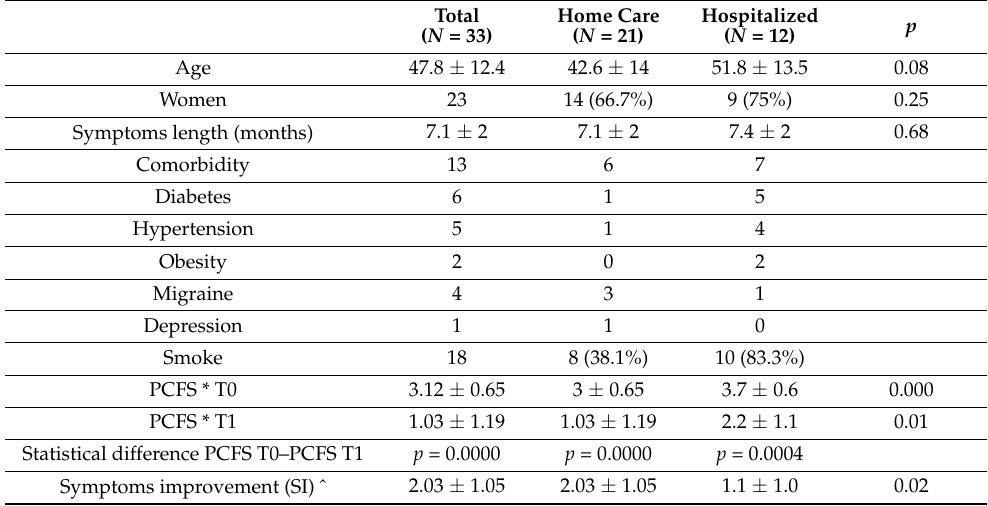
Table 2. Clinical features of outpatients’/home care and hospitalized patients treated with